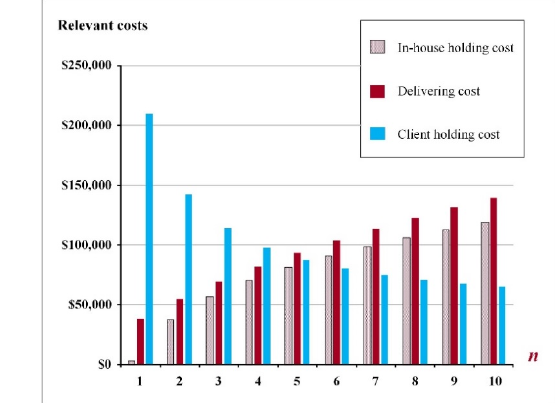
Fig. 7. Various sensitive expenses relating to